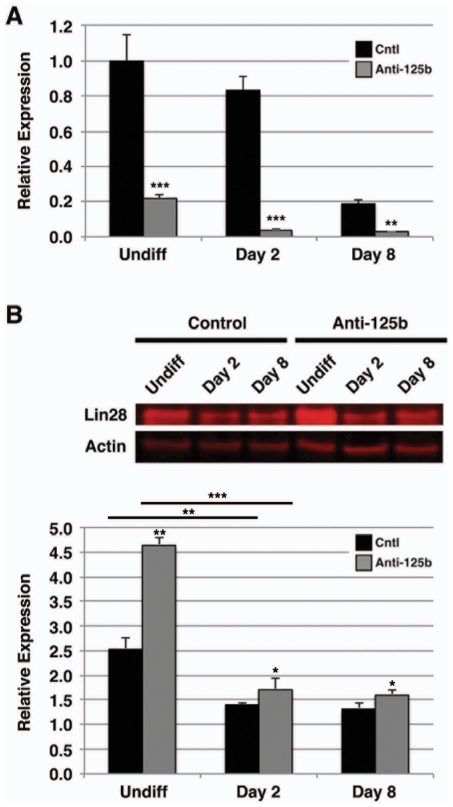
Lin28 expression is controlled by miR-125b in differentiating hESCs.Untransfected hESCs (Cntl) or hESCs transfected with anti-miR-125b inhibitor (anti-125b) were cultured in differentiation medium for 2 or 8 days. A) Cells were analyzed for expression of miR-125b by qPCR. Appropriate downregulation of mature miR-125b was seen in both undifferentiated and differentiating hESCs. Data shown are mean±s.e.m. (N = 3). **, p<0.01; ***, p<0.001. B) Cell lysates were assayed for Lin28 by immunoblot analysis compared to undifferentiated cells (Undiff). Lin28 protein expression was noticeably decreased in hESCs differentiated for 2 or 8 days compared to undifferentiated cells, while transfection with anti-125b induced Lin28 expression in undifferentiated as well as differentiating cells (TOP). Actin was used as a loading control. Representative results are shown. Quantitation of fluorescent signals is shown (BOTTOM). Data shown are mean±s.e.m. (N = 3). *, p<0.05; **, p<0.01; ***, p<0.001.